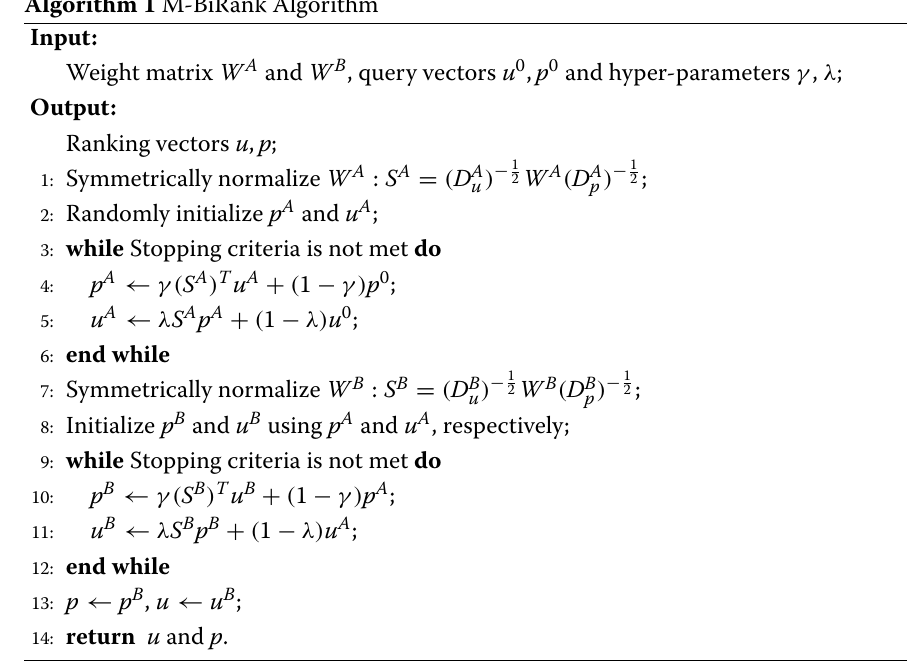
Algorithm 1 M-BiRank